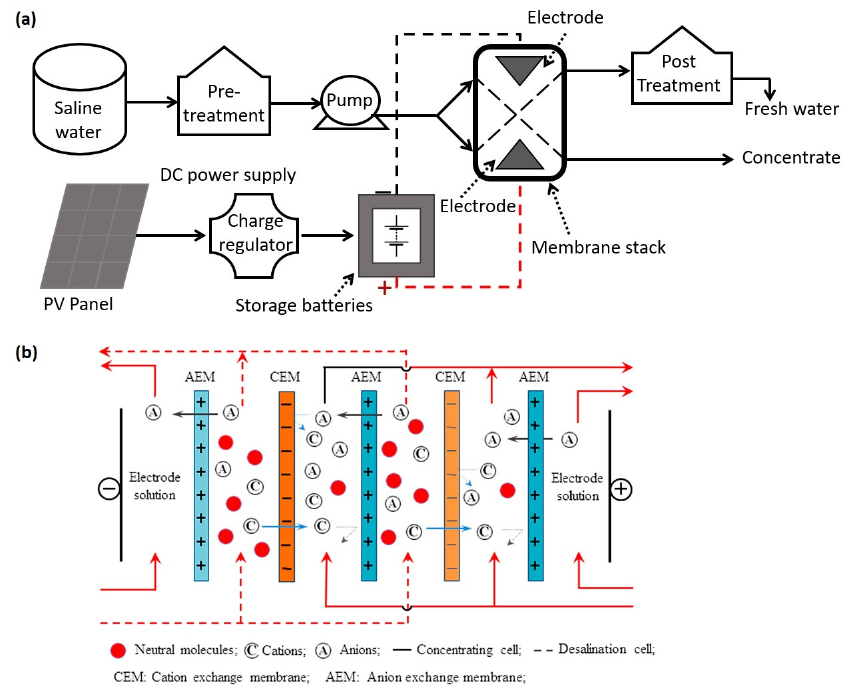
Figure 5. A schematic of a PV solar-driven ED system ( a ) and an electrodialysis stack ( b ). Sub-figure ( b ) is adopted from [89] and reused under the Creative Commons license.